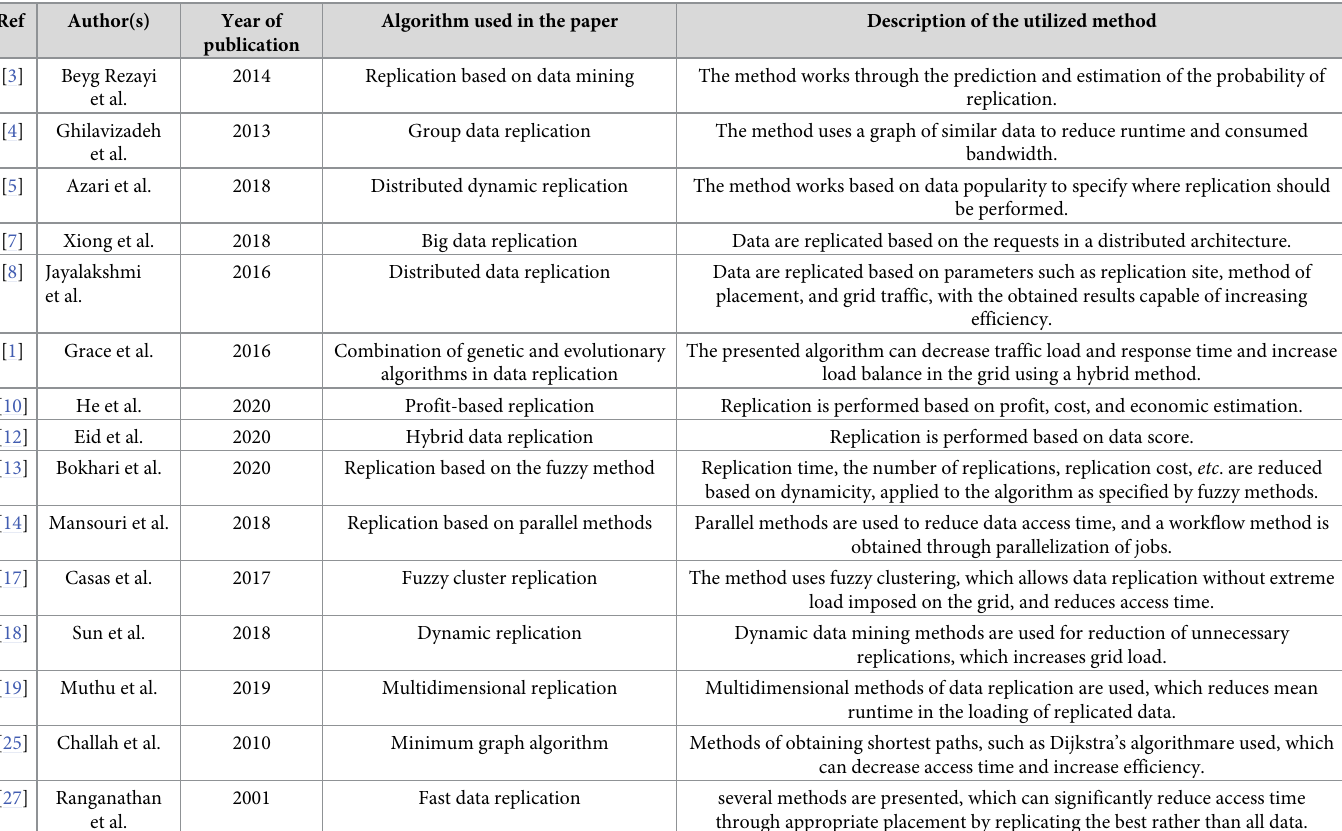
Table 1. A summary of the reviewed